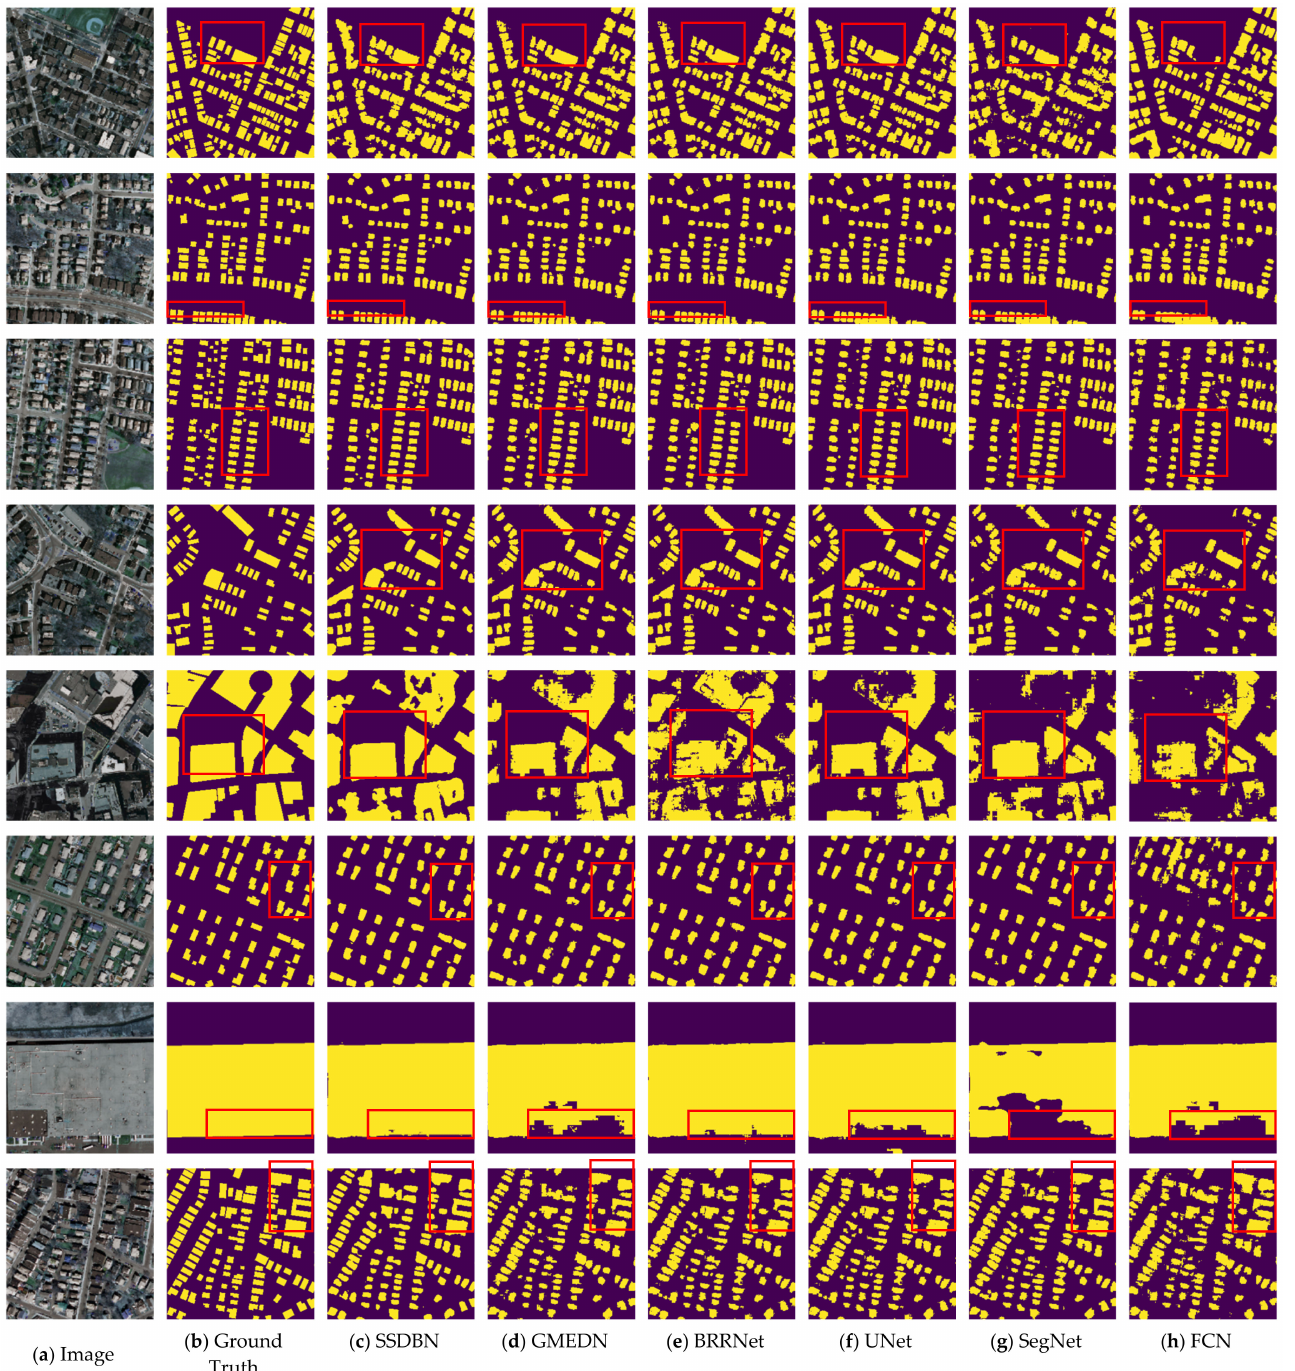
Figure 7. Prediction of different models on the Massachusetts Building Dataset. ( a ) Input image; ( b ) ground true; ( c ) the result of our method of SSDBN; ( d ) the result of GMEDN; ( e ) the result of BRRNet; ( f ) the result of UNet; ( g ) the result of SegNet; ( h ) the result of FCN. The red boxes indicate the more obvious extraction